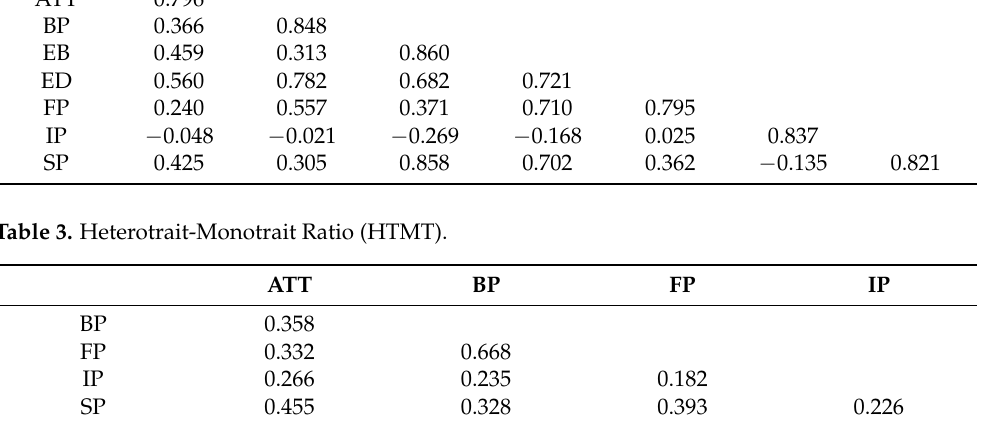
Table 2. Discriminant validity—Fornell–Larcker Criterion. ATT